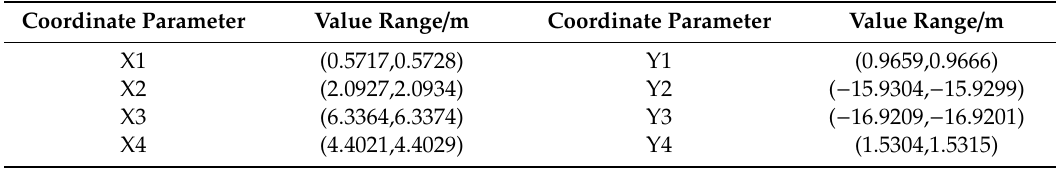
Table 2. Value range of coordinate parameters at the 95% confidence interval.